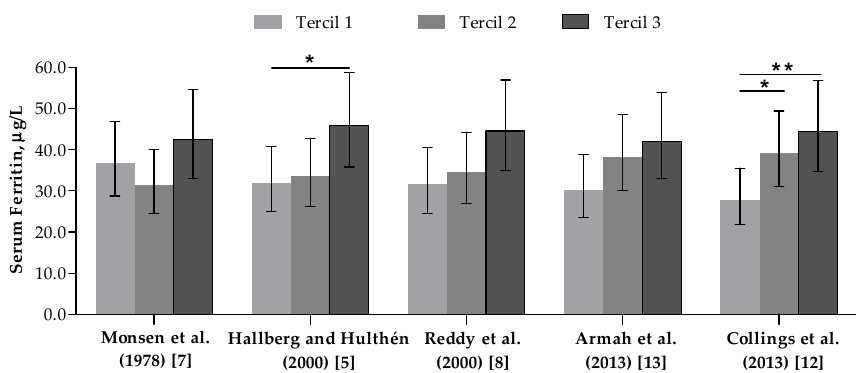
Figure 3. Serum ferritin (µg/L) of women classified according to tertiles of bioavailable iron intake (mg/day). n = 127. Bars and whiskers indicate geometric mean and 95% confidence intervals, respectively. * p < 0.05, ** p < 0.01—in comparison to the first tertile, according to multiple linear regression adjusted for age, body mass index, skin color/race, physical activity level, hormonal contraceptives use and menstrual flow intensity level.